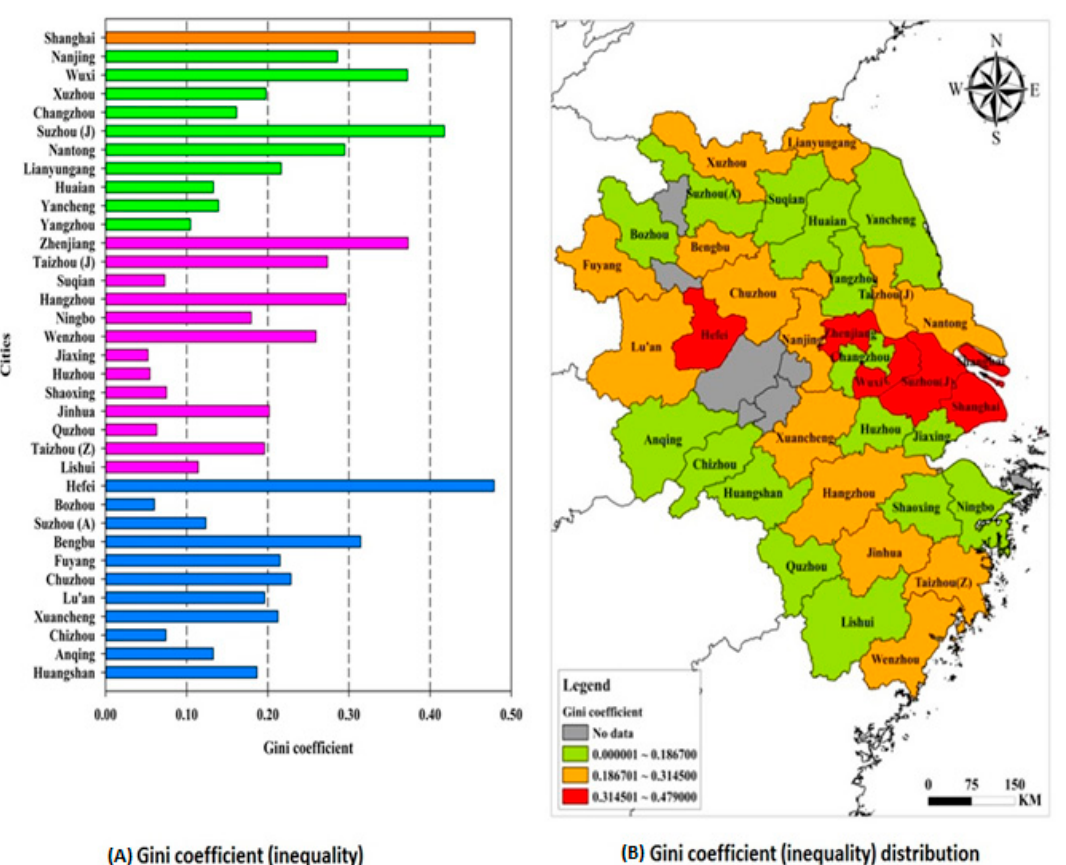
Figure 4. Inequality level ( A ) and distribution ( B ).